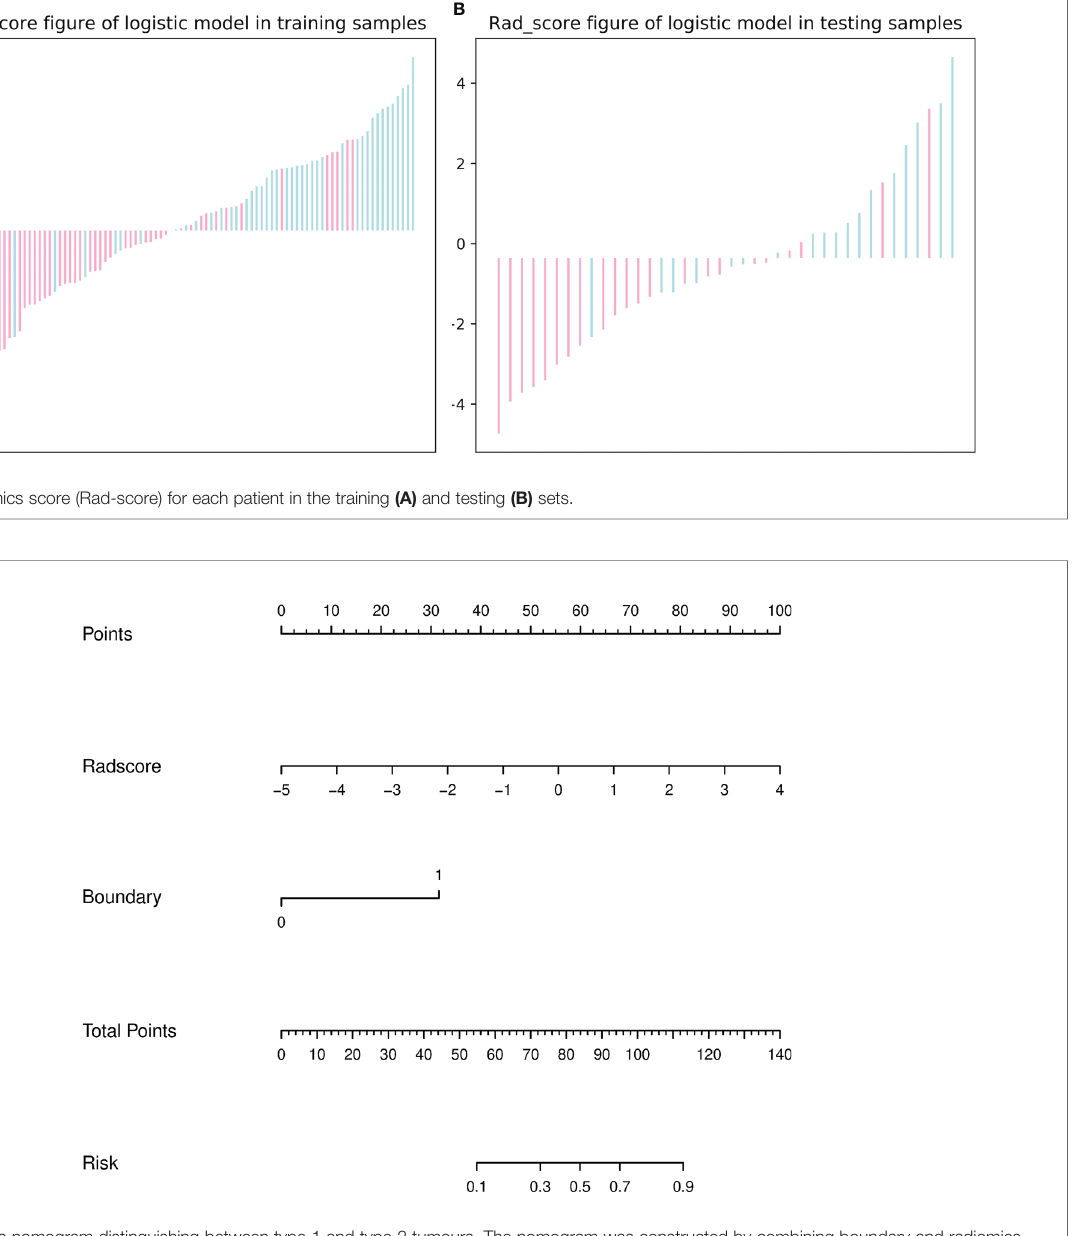
FIGURE 6 | A radiomics nomogram distinguishing between type 1 and type 2 tumours. The nomogram was constructed by combining boundary and radiomics score (Rad-score) on the basis of a training cohort. The corresponding points are estimated from the boundary and Rad-score values, and these are added together to obtain total points. The likelihood of type 2 pRCC was estimated from the total points, the greater the total points, the greater the probability of type 2